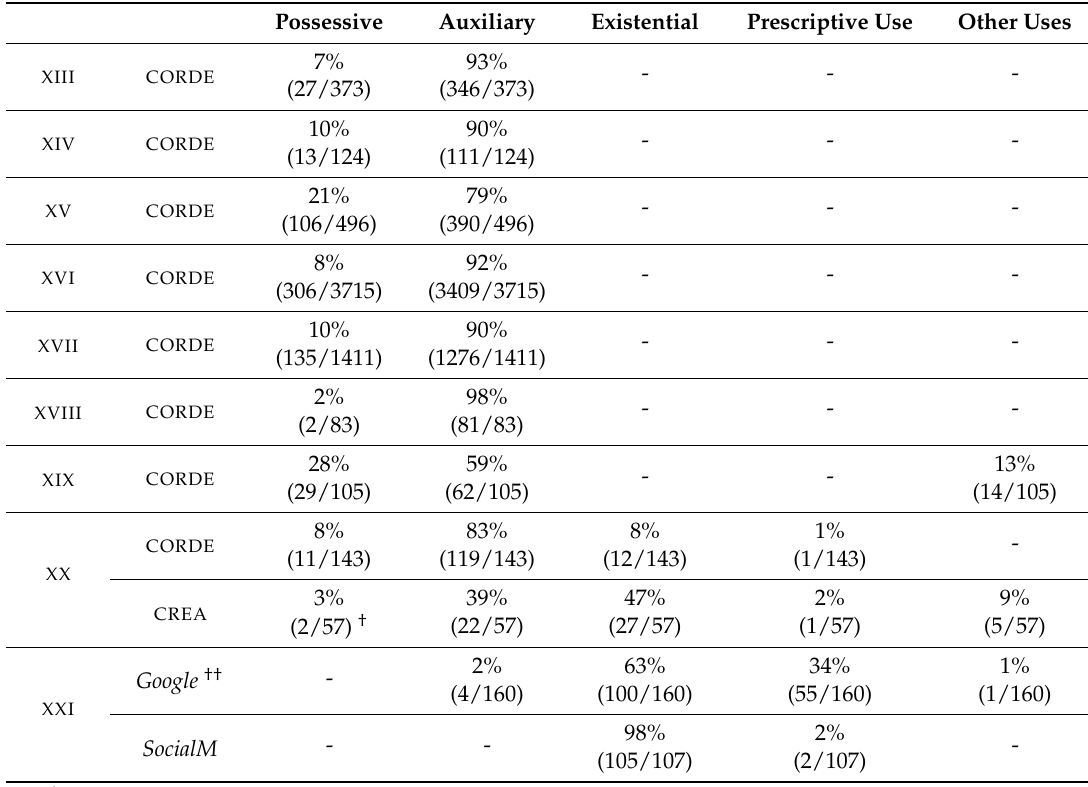
Table 3. Recorded meaning of habemos ( avemos